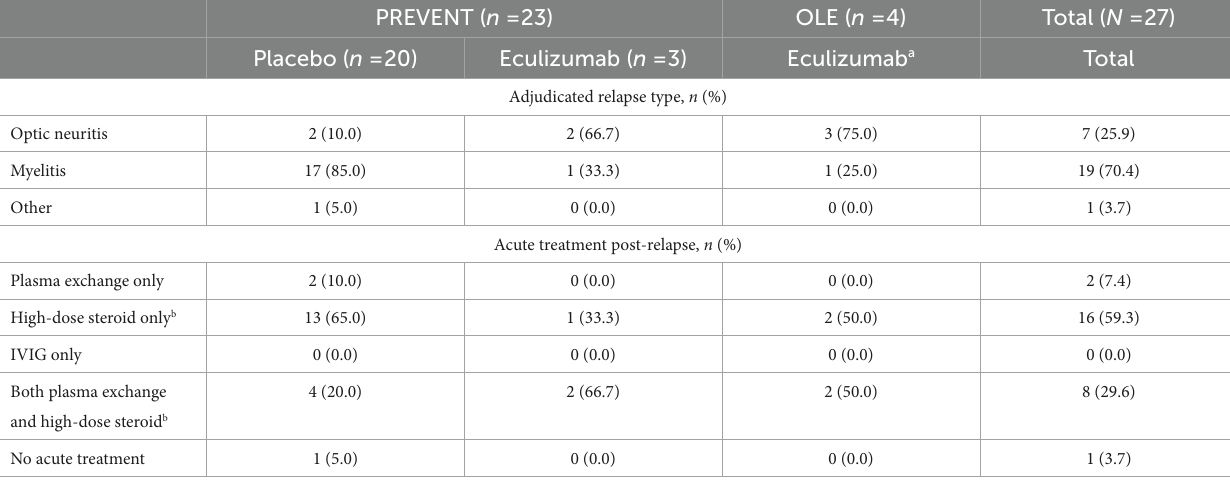
TABLE 1 Clinical characteristics of relapsing